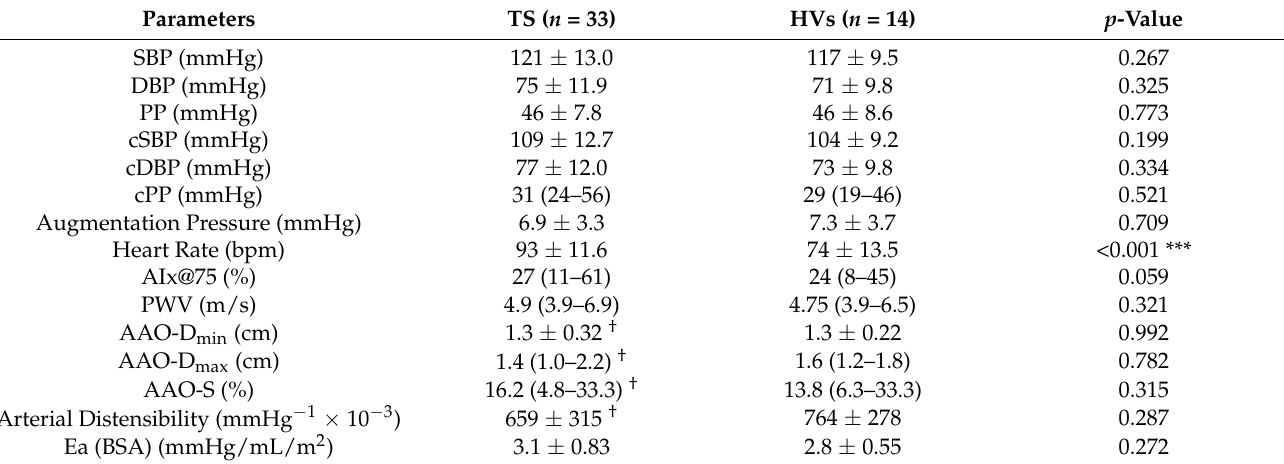
Table 1. Vascular function in Turner Syndrome patients (TS) and healthy volunteers (HVs).